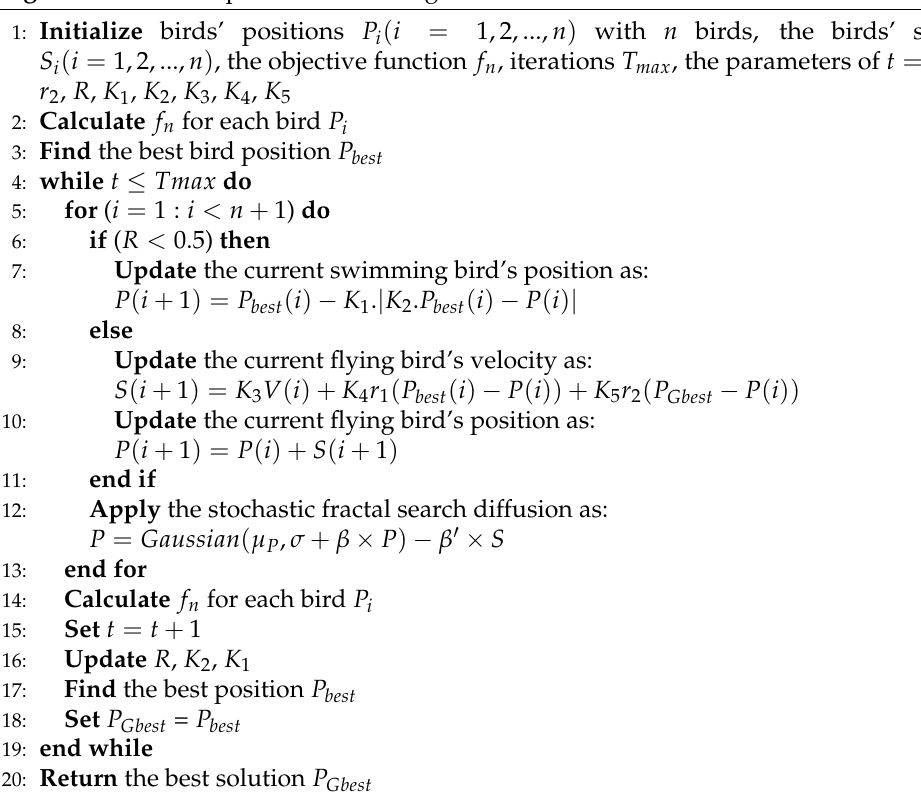
Algorithm 1 The Proposed DTOSFS Algorithm